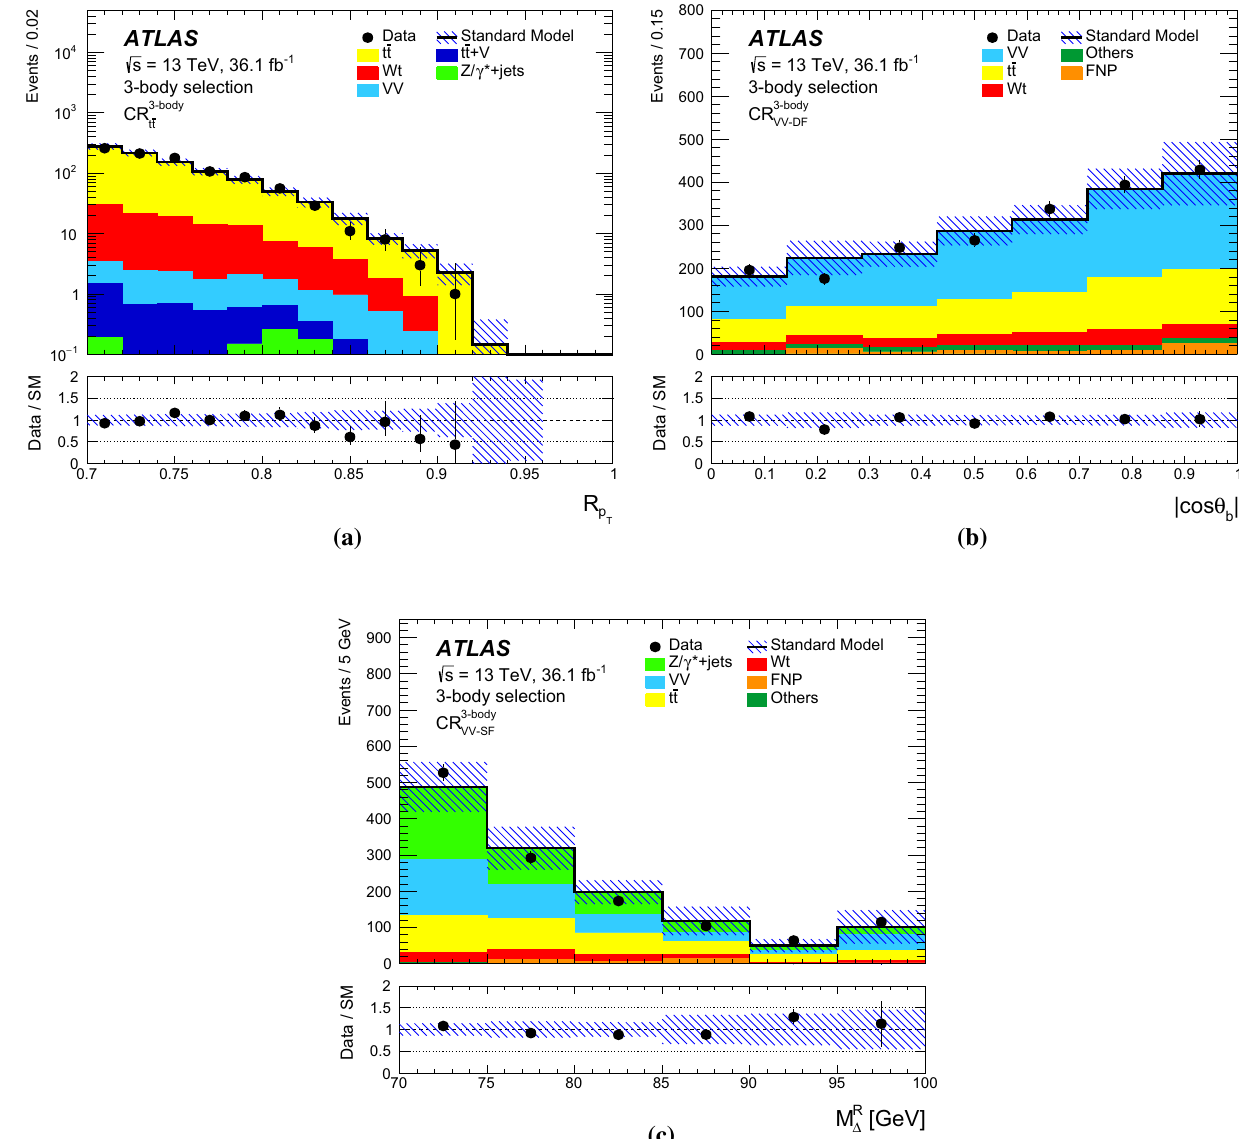
Fig. 3 Three-body selection distributions of a R p stack; the hatched bands represent the total uncertainty in the back- in CR 3-body , b t ¯ t T ground predictions after the fit to the data has been performed. The , and c M R (cid:10) in CR 3-body after the background fit. cos θ b in CR 3-body VV -DF VV -SF counting uncertainty on data is also shown by the black error bars. The The contributions from all SM backgrounds are shown as a histogram rightmost bin of each plot includes overflow